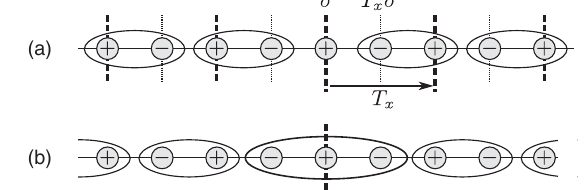
FIG. 3. Panel (a) depicts a system with mirror reflection σ and discrete translation symmetry generated by T x normal to the mirror plane. Each point on the line represents a 2D plane, and there are two inequivalent types of mirror planes. One type (thick dashed lines) is obtained by translating the σ plane, and the other type (thin dotted lines) is obtained by translating the T x σ plane, which is separated from the σ plane by half a lattice. In this setting, we can have a stack of alternating-chirality E 8 states, where þ = − represent E 8 states with n E ¼ (cid:2) 1 on the two types of 8 mirror planes. Reduction to 2D can be visualized by pairing E 8 states away from the mirror plane as shown, leaving an n E ¼ þ 1 8 state on the mirror plane. A different reduction procedure is illustrated in (b), where states are grouped to give an n E ¼ − 1 8 state on the mirror